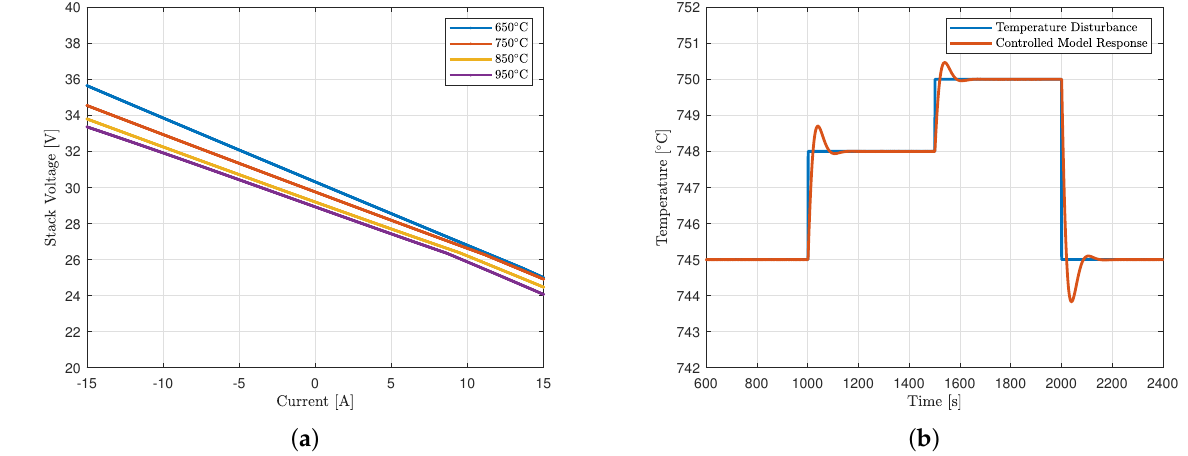
Figure 5. Thermal analysis. ( a ) Temperature effects on the controlled reversible stack. ( b ) Temperature disturbances on the controlled reversible